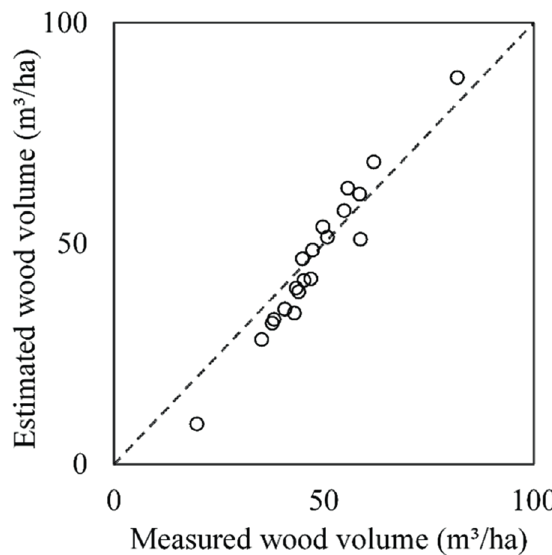
Figure 2 - Scatterplots of the predicted vs. observed wood volume in Cerrado Sensu Stricto in the state of Minas